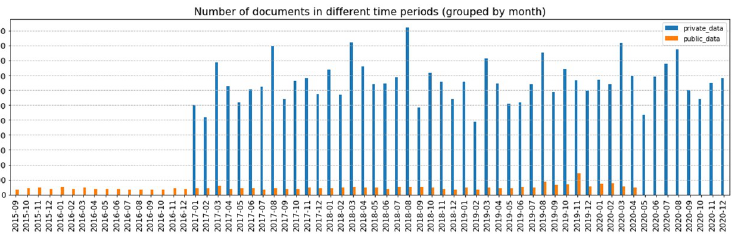
Fig 8. Number of documents per month in the public and private data